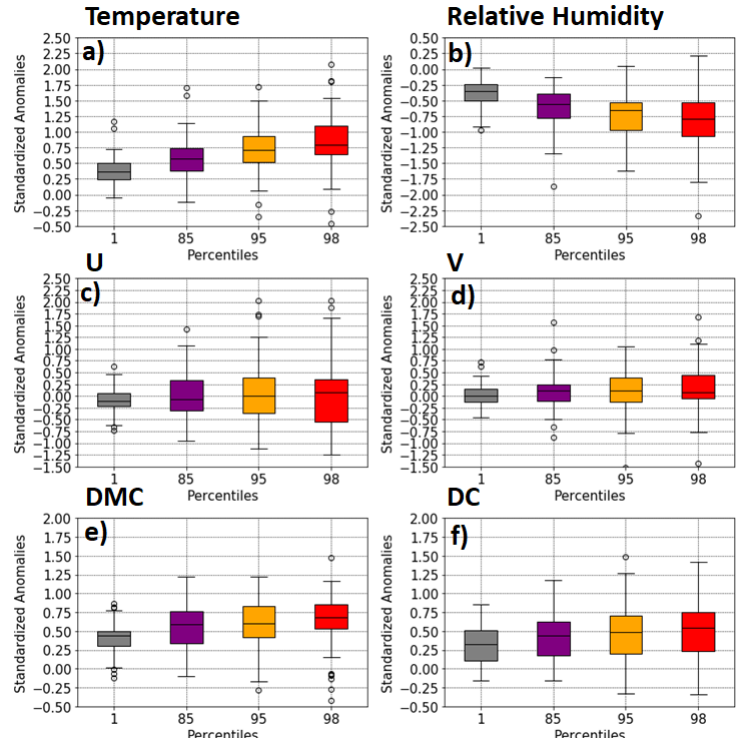
Figure 3. Standardized anomalies for the ignition days of ( a ) temperature, ( b ) relative humidity, ( c ) zonal (U) and ( d ) meridional (V) velocity of the wind, ( e ) Du ff Moisture Code (DMC) and ( f ) Drought Code (DC) in the Iberian Peninsula according to the final burned area percentiles 1 (gray), 85 (purple), 95 (orange), and 98 (red).